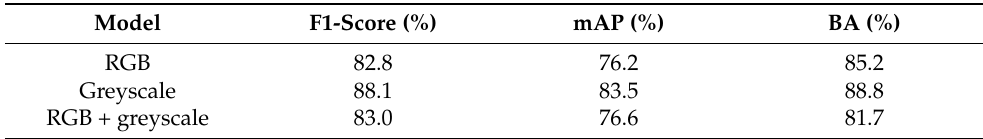
Table 7. Different evaluation metrics results for YOLO v4 model